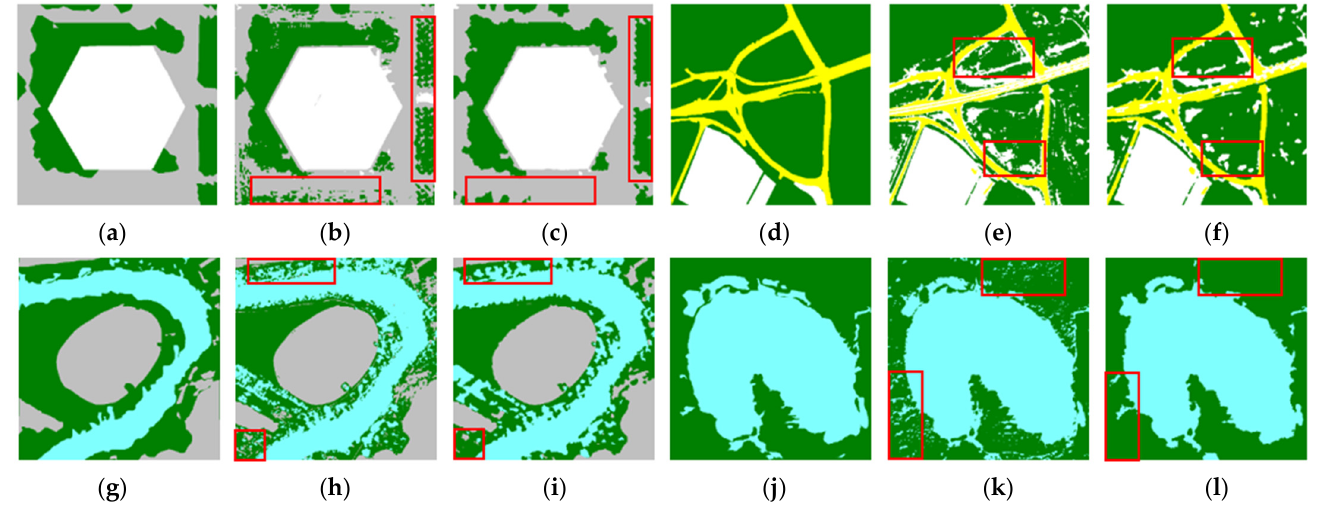
Figure 3. Experimental results. The red rectangle boxes are selected as the comparison areas. ( a ) S1 reference images, ( b ) S1 sIFCM, ( c ) S1 SSIFCM, ( d ) S2 reference images, ( e ) S2 sIFCM, ( f ) S2 SSIFCM, ( g ) S3 reference images, ( h ) S3 sIFCM, ( i ) S3 SSIFCM, ( j ) S4 reference images, ( k ) S4